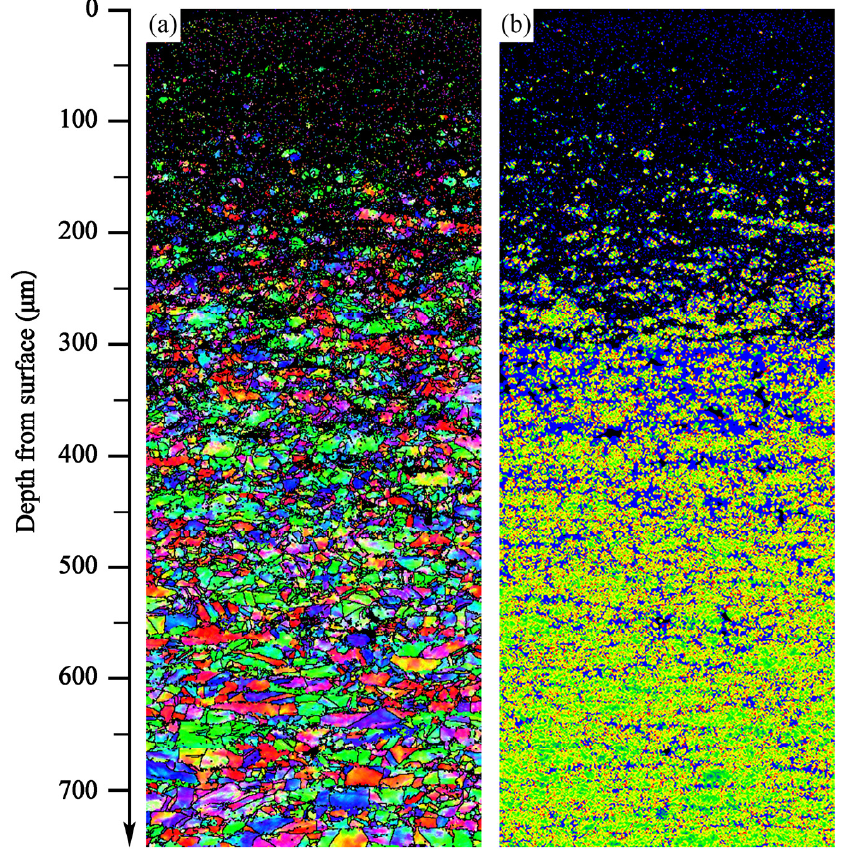
Figure 2. Typical longitudinal section EBSD result of the SS-USSR sample from the top surface: ( a ) IPF map, ( b ) KAM map.